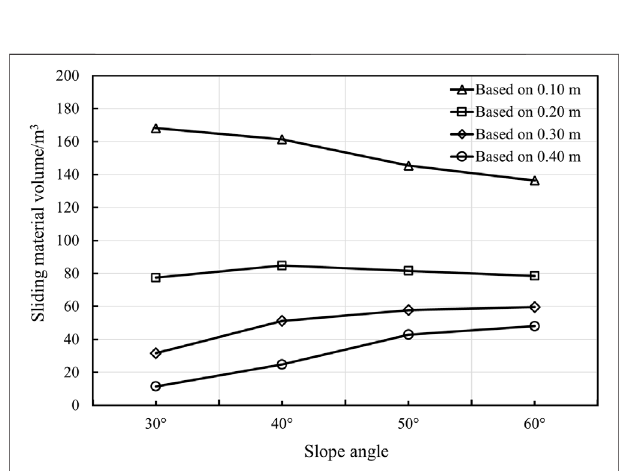
FIGURE 9 | Sliding material volume change curves of slopes with slope angles under different deformation thresholds (The longitudinal length of the slope is assumed to be 1.00 m).